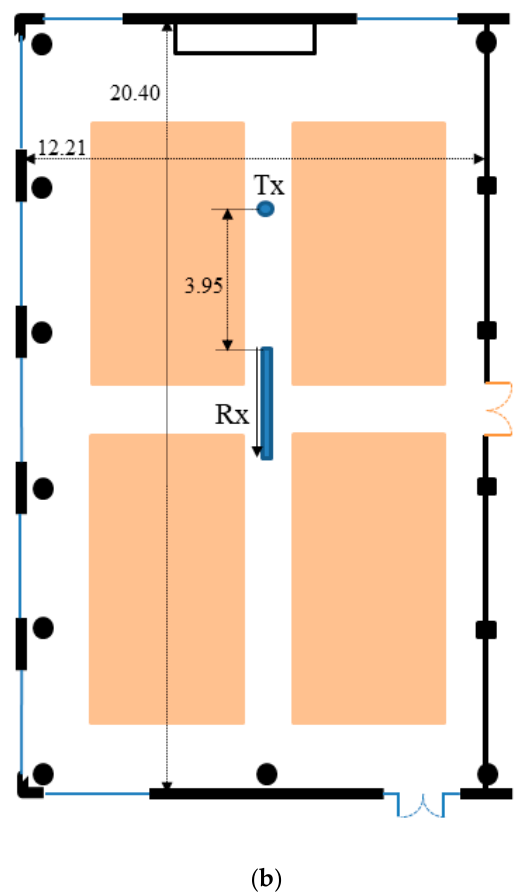
Figure 3. Description of the auditorium environment: ( a ) Picture; ( b ) floor plan with dimensions in m.